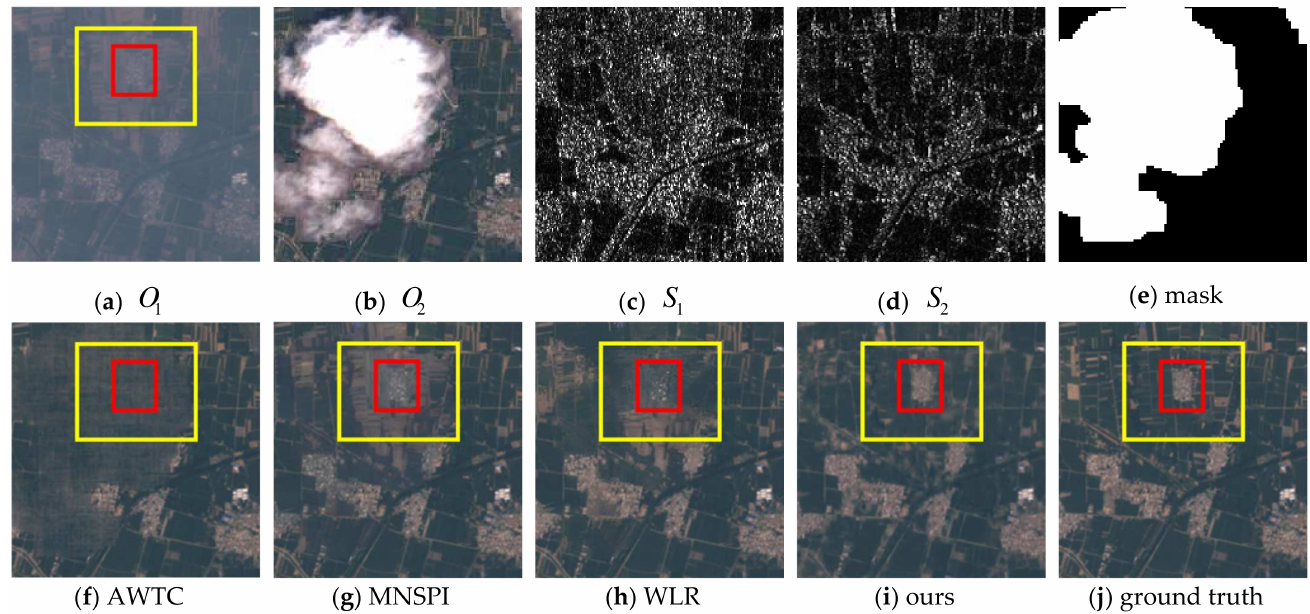
Figure 4. Magnified area 2 of simulation experiment results. The area boxed in red is the town area while the surrounding area boxed in yellow is the agricultural area. In O 1 they share the same spectral information while in the ground truth they have totally different spectral information. The three comparison methods either reconstruct the town area into agricultural area or the agriculture area into town area. Our method can distinguish the two kinds of ground objects.